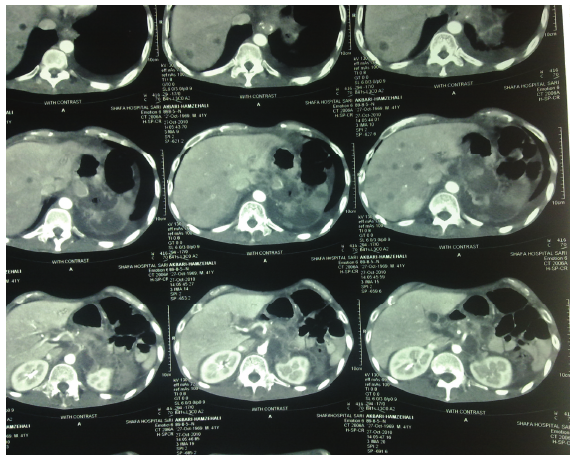
Figure 5: Abdominal CT Scan with